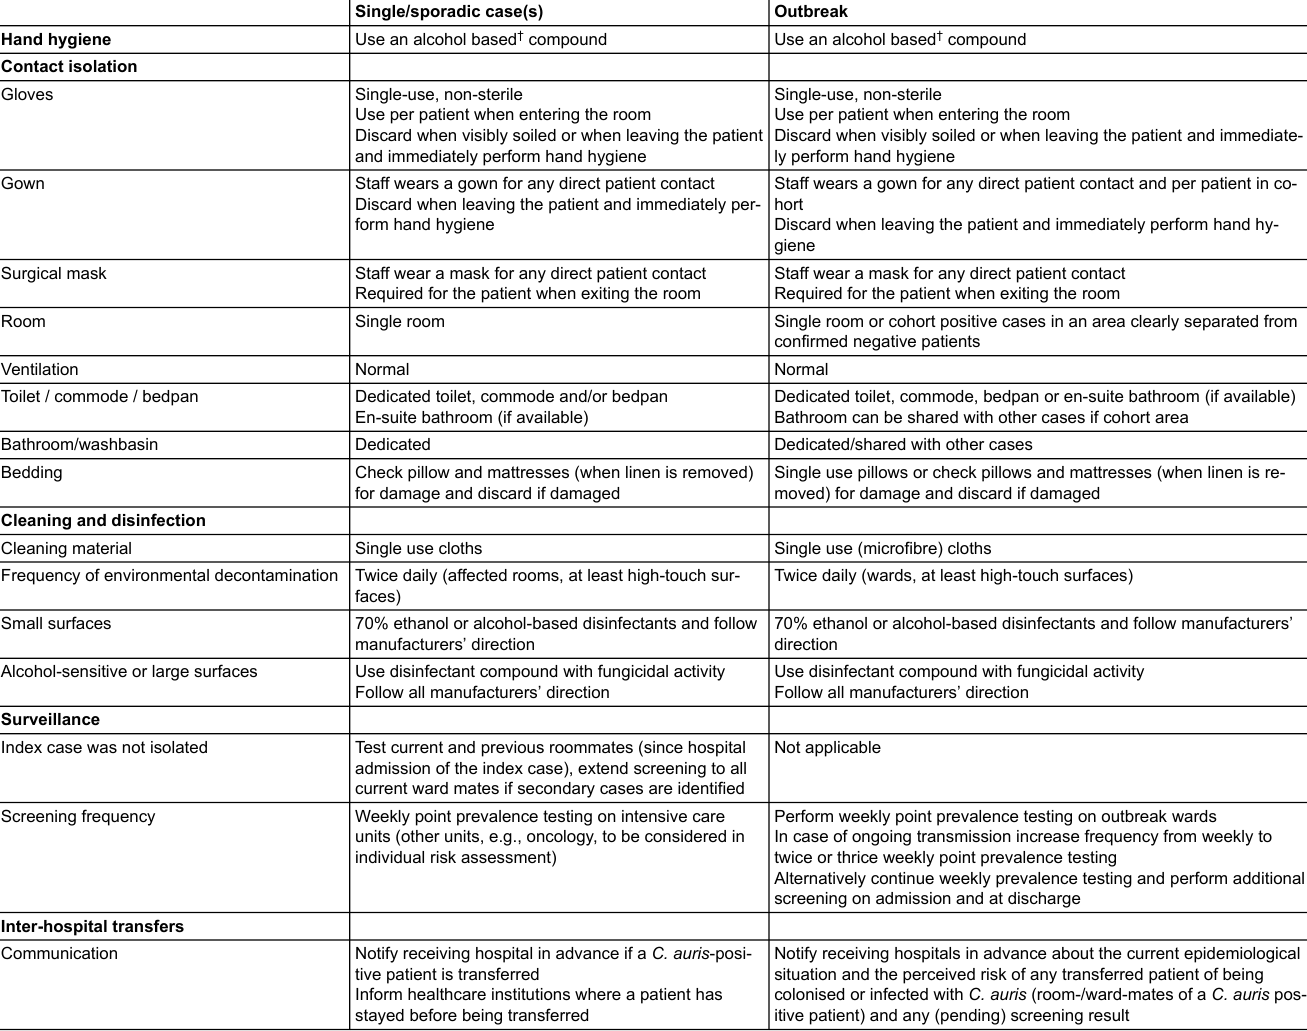
Table 3: Overview of infection prevention and control measures for C. auris single cases and outbreaks. Adapted from Kenters et al. [27] * . Single/sporadic